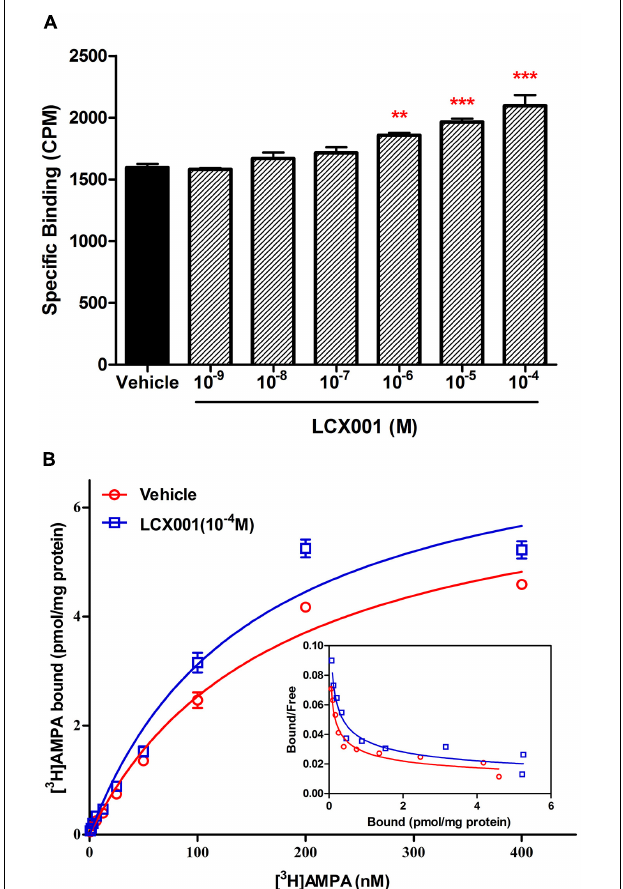
FIGURE 3 | LCX001 facilitated [ 3 H]AMPA binding. (A) Effects of preincubation of LCX001 at increasing doses (10 − 9 –10 − 4 M) on [ 3 H]AMPA binding. The specific binding of [ 3 H]AMPA to AMPA receptors in tissues was significantly improved in the presence of LCX001 at 10 − 6 , 10 − 5 , and 10 − 4 M. ∗ Significant difference by one-way ANOVA, Dunnett’s test (LCX001 treatment groups vs. vehicle group; ∗∗ P < 0.01, ∗∗∗ P < 0.001); mean ± SEM, three separate experiments were performed in triplicate. (B) Saturation binding curves and Scatchard plots (inset) of [ 3 H]AMPA binding in the preincubation and absence from LCX001 (10 − 4 M). The concentrations of [ 3 H]AMPA were set to 400 nM. The results were analyzed by one-site logistic curve-fitting equation, and the K d and B max values given in the text indicated that binding affinity and the number of binding sites were increased after treatment of LCX001. The K d and B max values were individually mentioned in the text. Values are the mean ± SEM of results from six separate experiments. LCX001 treatment (vehicle group vs. LCX001, student’s paired t -test, ∗ P <